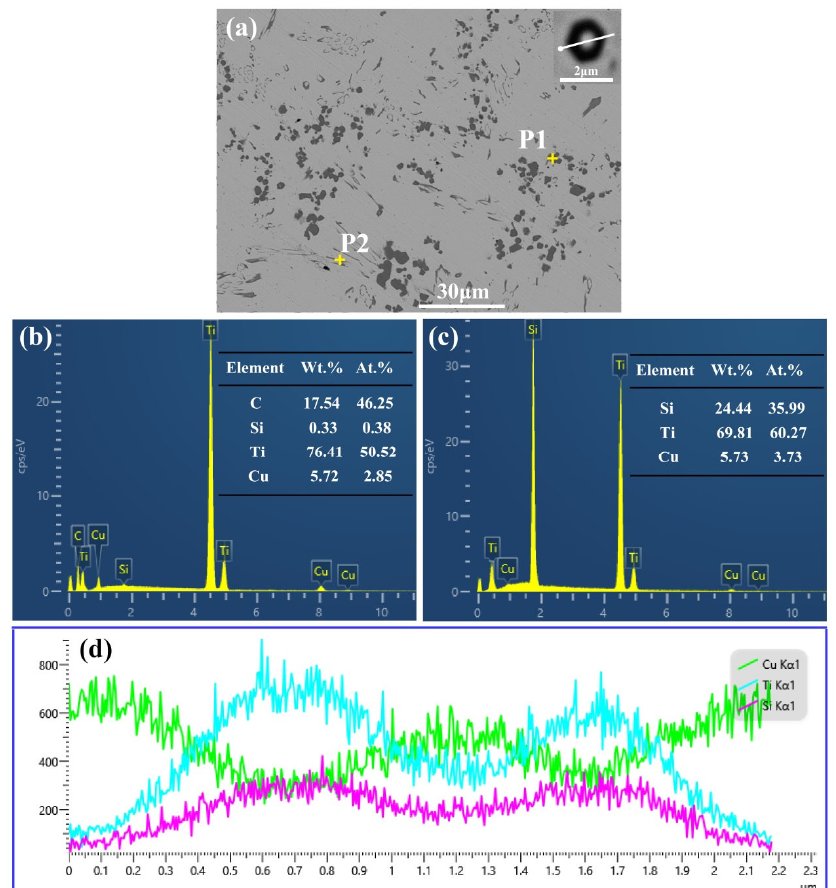
Figure 2. EDS analysis of the synthesized TiC and Ti 5 Si 3 in the Cu-4.86Ti-1Si-0.43C sample. ( a ) The microstructure of the Cu-4.86Ti-1Si-0.43C sample; ( b , c ) EDS point analysis result of P1 and P2, respectively; ( d ) The EDS line analysis results of the Cu@Ti x Si y core–shell structure phase.